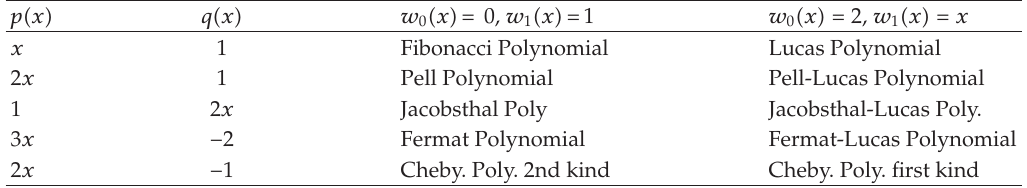
Table 1: Special cases of the w (cid:2) x (cid:3) with given initial conditions are given. p (cid:2) x